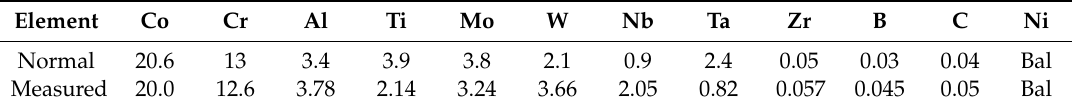
Table 1. Composition of atomized Ren é 104 Ni-based superalloy powder (wt.